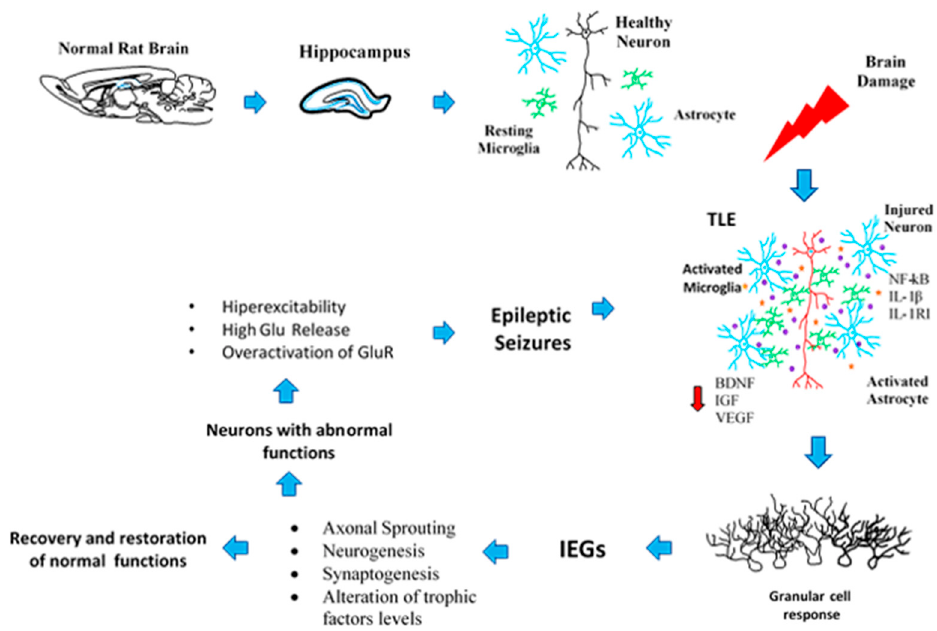
Figure 3. Schematic representation of the progressive events that lead to neuroplasticity and epileptogenic processes. First, the upper images refer to the undamaged hippocampus (blue colour) in a rat brain with most of the diverse cell populations (layers) represented (neuron: black colour; astrocytes: blue colour; and microglial cells: green colour). After non-lethal damage to the brain (red ray), reactive glial cells release pro-inflammatory chemokines and cytokines and modify neuronal activity (neuron: red colour; astrocytes: blue colour, and microglial cells: green colour; released pro-inflammatory molecules: purple colour; trophic factors levels are altered: red arrow). Then, through IEGs transcription, dentate granular cells respond to the damage through plastic changes that try to restore normal function but can also contribute to epileptogenesis, in a global process where in the mechanisms could affect on another.